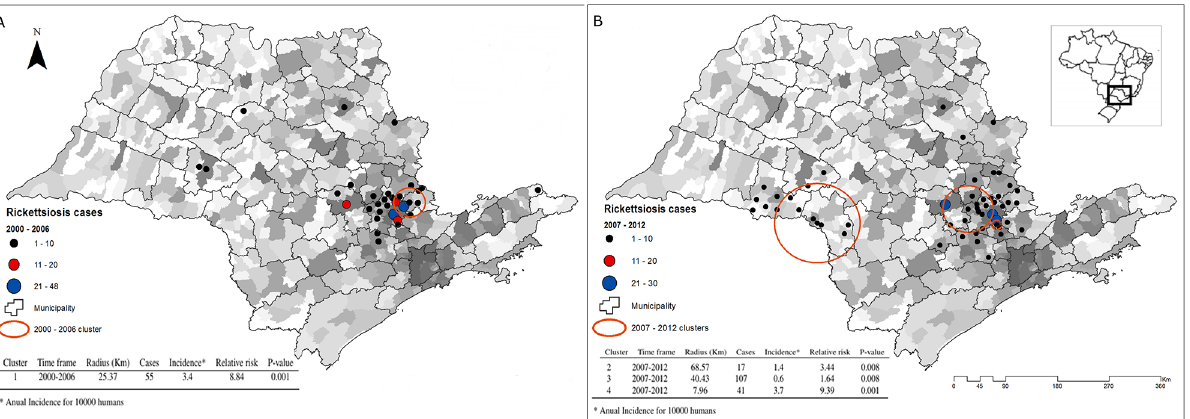
Fig 1. Population density and Rickettsiosis occurrence in areas of transmission by Amblyomma cajennense sensu lato in the state of S ã o Paulo. High population density is represented with a higher gray tone and low population density with a lower gray tone. (A) Cases reported and cluster detected from 2000 to 2006. (B) Cases reported and clusters detected from 2007 to